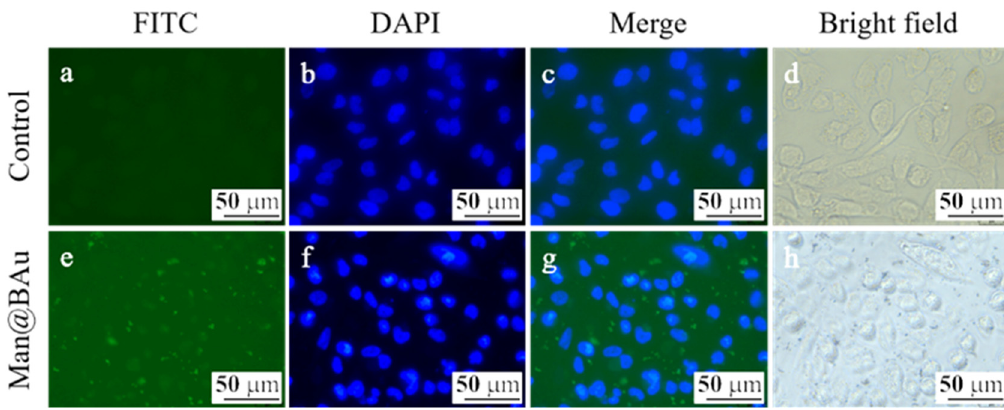
Figure 5. Fluorescent microscopic images of MDA-MB-231 cells ( a – d ). MDA-MB-231 cells incubated with FITC-Man@BAu (green, e ). Nucleus was labeled with DAPI (blue) ( f ), merge ( g ), bright field ( h ).